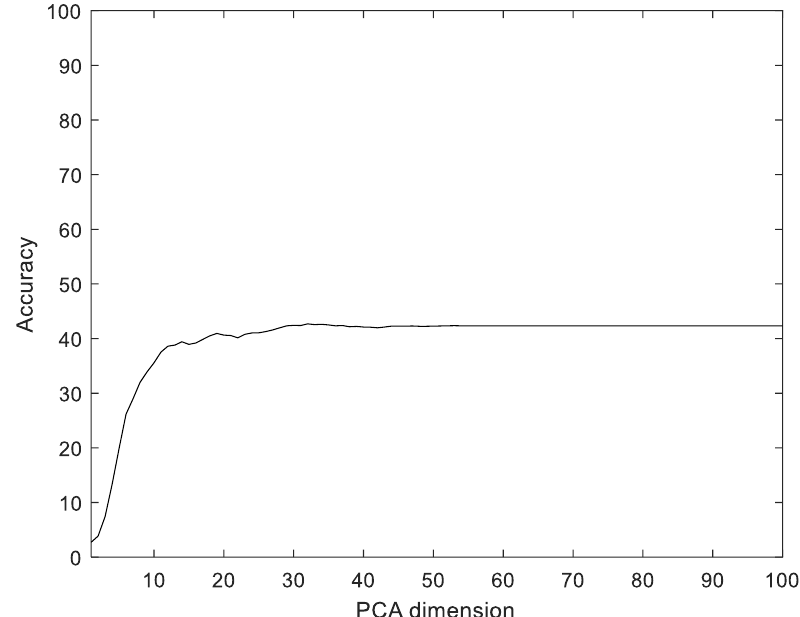
Figure 12. Recognition rate of PCA according to PCA dimensions on CU-EMG-ECG dataset.